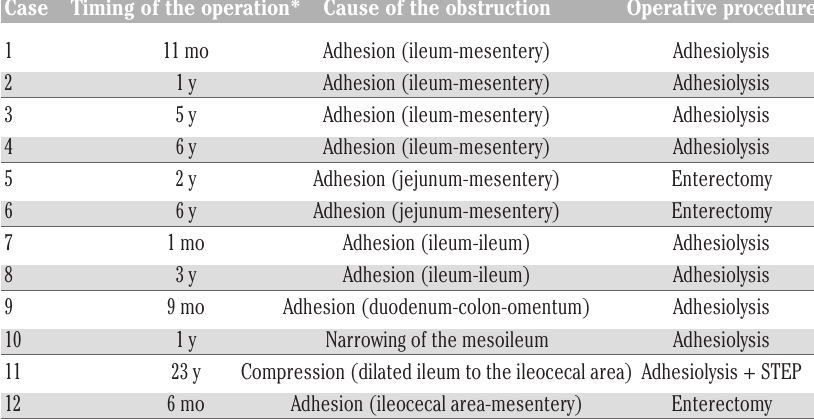
Table 2. Intraoperative findings at